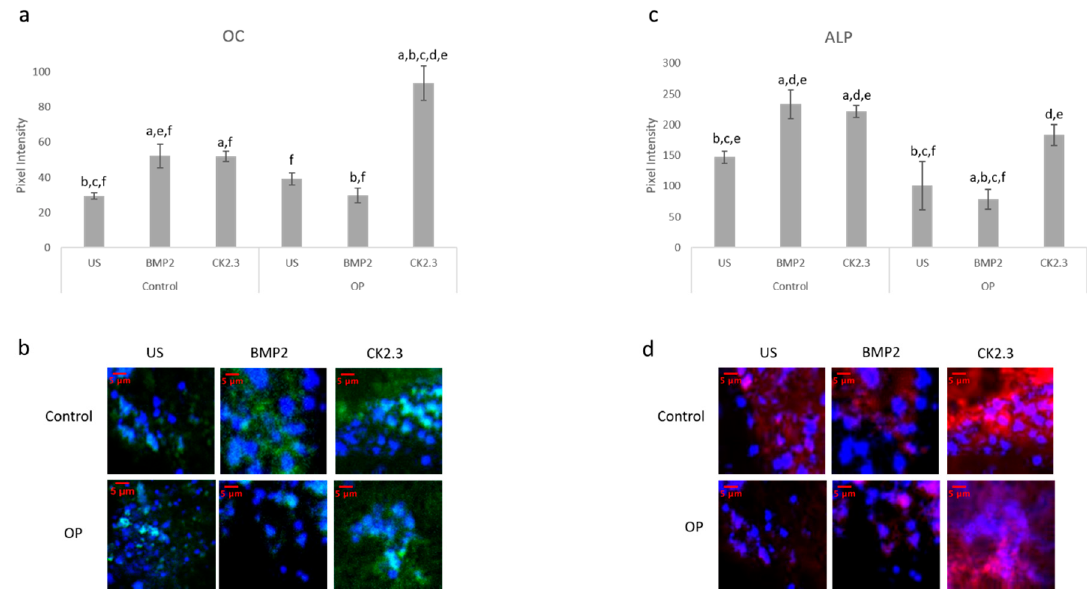
Figure 4. Explants from OP and control patients were prepared as previously described and stimulated with BMP2, CK2.3, or left US. After the fifth day the explants were fixed and stained for OC (green), ALP (red), and the nucleus (blue). ( a ) Control and OP explants stimulated with CK2.3 significantly increased expression of OC when compared to US and BMP2 stimulation. OP explants stimulated with BMP2 significantly decreased expression of OC. ( b ) Representative 2D images depicting the nuclear stain overlayed with the OC stain. ( c ) Both control and OP explants stimulated with CK2.3 significantly increased expression of ALP when compared to control and BMP2 stimulation. BMP2 stimulation significantly decreased ALP expression in both control and OP explants. ( d ) Representative 2D images depicting the nuclear stain overlaid with the ALP stain. Error bars represent standard error of the mean (SEM). “a” denotes statistically significant to control US explants, “b” denotes statistically significant to control BMP2 stimulated explants, “c” denotes statistically significant to control CK2.3 stimulated explants, “d” denotes statistically significant to OP US explants, “e” denotes statistically significant to OP BMP2 stimulated explants, and “f” denotes statistically significant to OP CK2.3 stimulated explants ( p < 0.05).